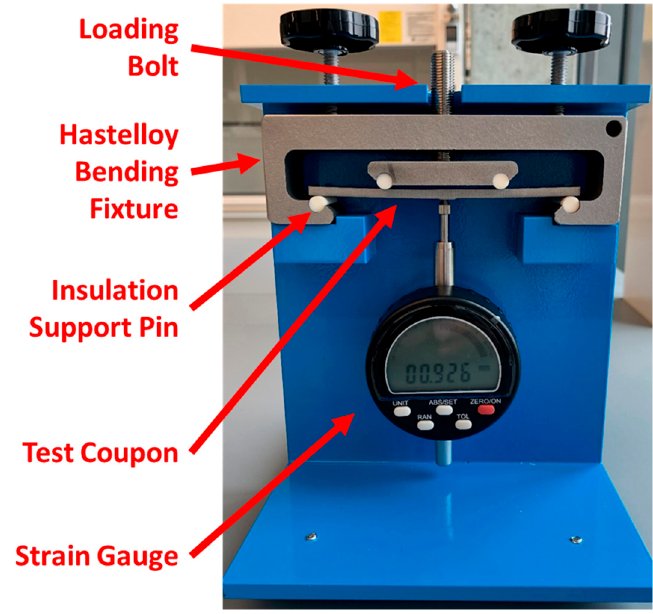
Figure 2. Four-point bend apparatus [50]. Reprinted/adapted with permission from Reference [50]. To accelerate the stress corrosion cracking (SCC) initiation and growth, the bent cou- pons were immersed in boiling magnesium chloride (MgCl 2 ) in the Advanced Materials Laboratory at the University of New Mexico. The experimental setup is shown in Figure 3 [50]. Reagent-grade MgCl 2 hexahydrate flake was used to make the boiling solution. The coupon, while loaded in the four-point bending fixture, was fully immersed in the boiling MgCl 2 solution and constantly boiled at 155 ± 1 °C following the ASTM G36 standard [51] until a major crack occurred on the sample surface. More details about the sample prepa- ration and corrosion testing can be found in [50]. Figure 3. Boiling magnesium chloride test setup [50]. Reprinted/adapted with permission from Reference [50].